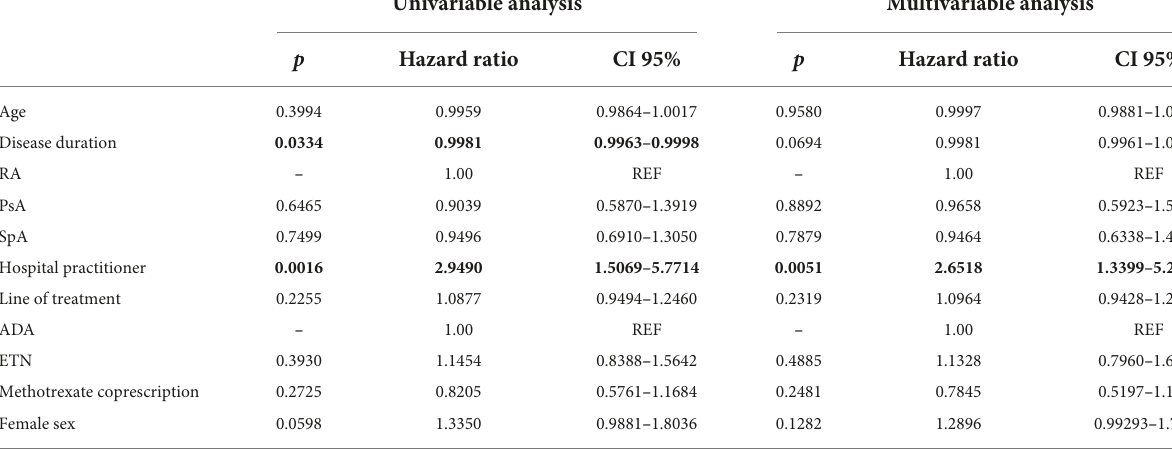
TABLE 4 Predictive factors of boDMARDs’ cessation in univariable and multivariable analyses.